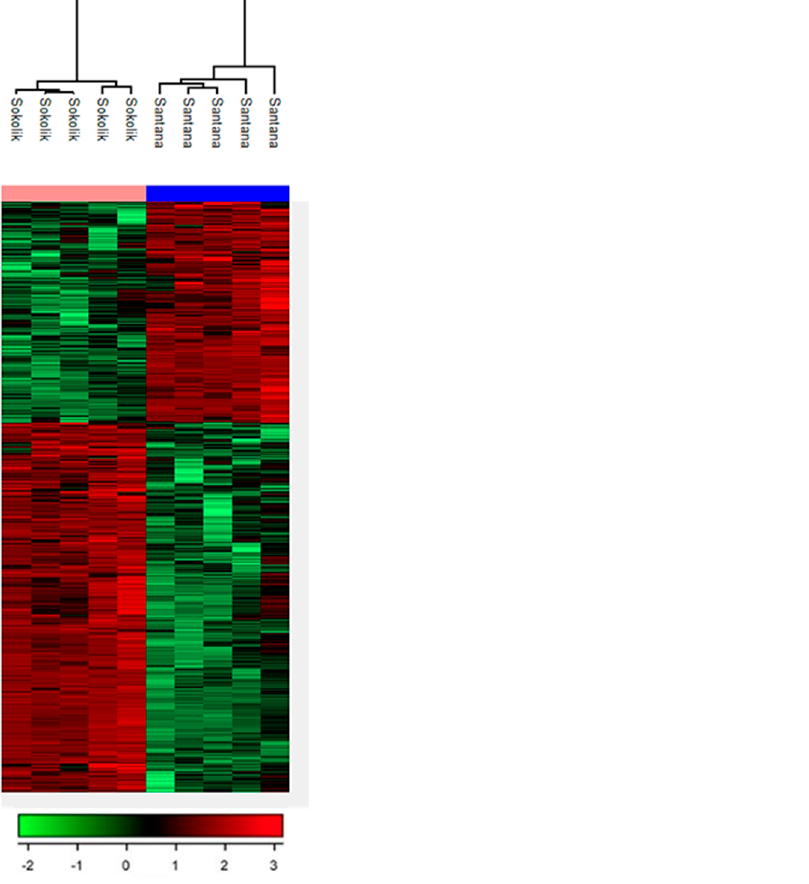
Figure 2. Heat map of significant metabolites reveals the metabolic signatures of Sokolik and San- tana pea cultivars. The hierarchical clustering shows two distinct clusters of metabolites, which could discriminate between the two cultivars. Table 2. Identification c haracteristics of the selected metabolites found differentially present in the extracts of Santana and Sokolik. (red color denotes higher quantities of the metabolite, green color denotes lower quantities of the